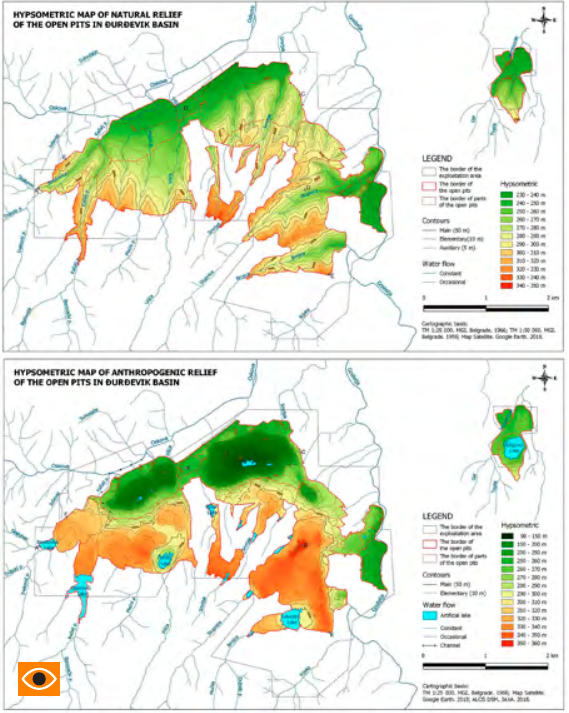
Figure 3. Hypsometric map of natural (up)